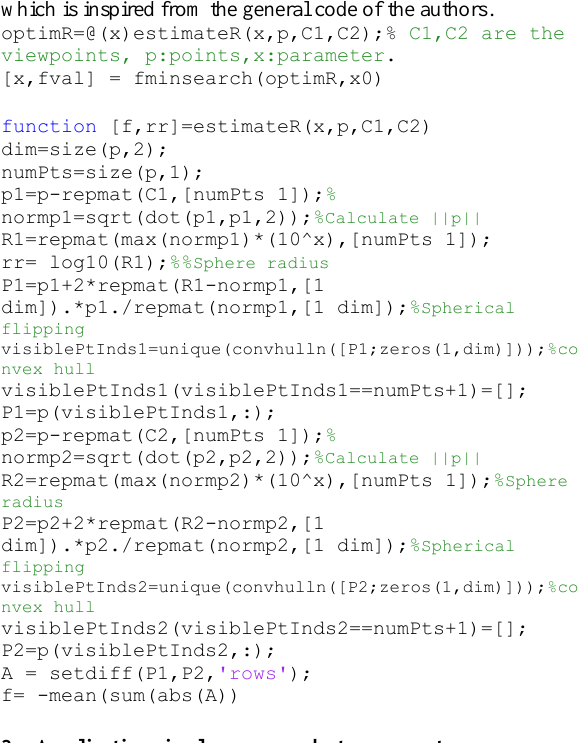
Figure 9. Depth buffering with voxels